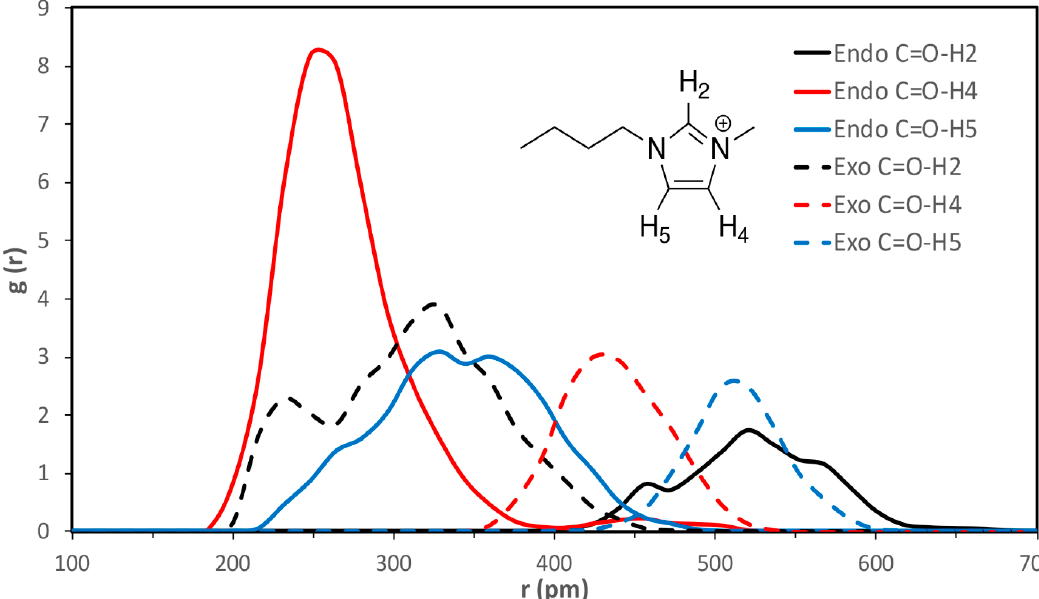
Figure 5. Nearest neighbor distribution for the endo-cis (solid lines) and exo-cis (dashed lines) Diels-Alder transition structures in [BMIM][PF 6 ] between the ring protons on BMIM (H2, H4 and H5) and the carbonyl oxygen of methyl acrylate using the OPLS-VSIL.